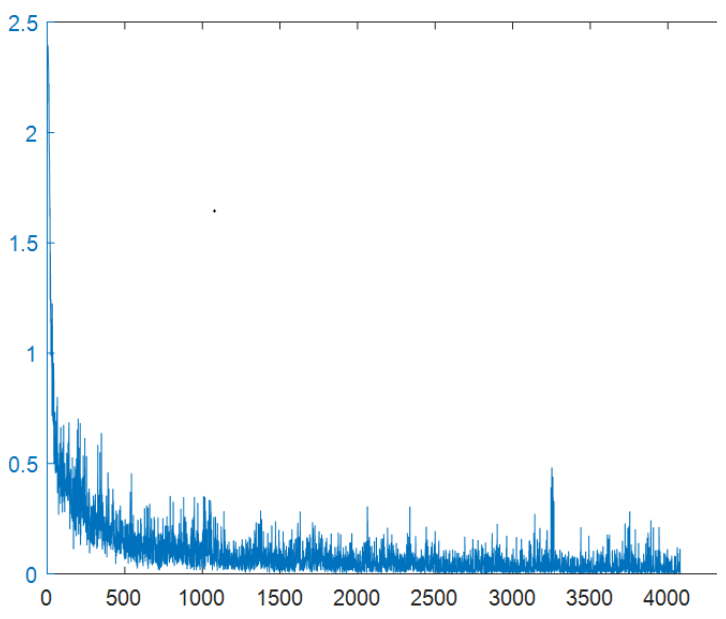
Figure 17. Training